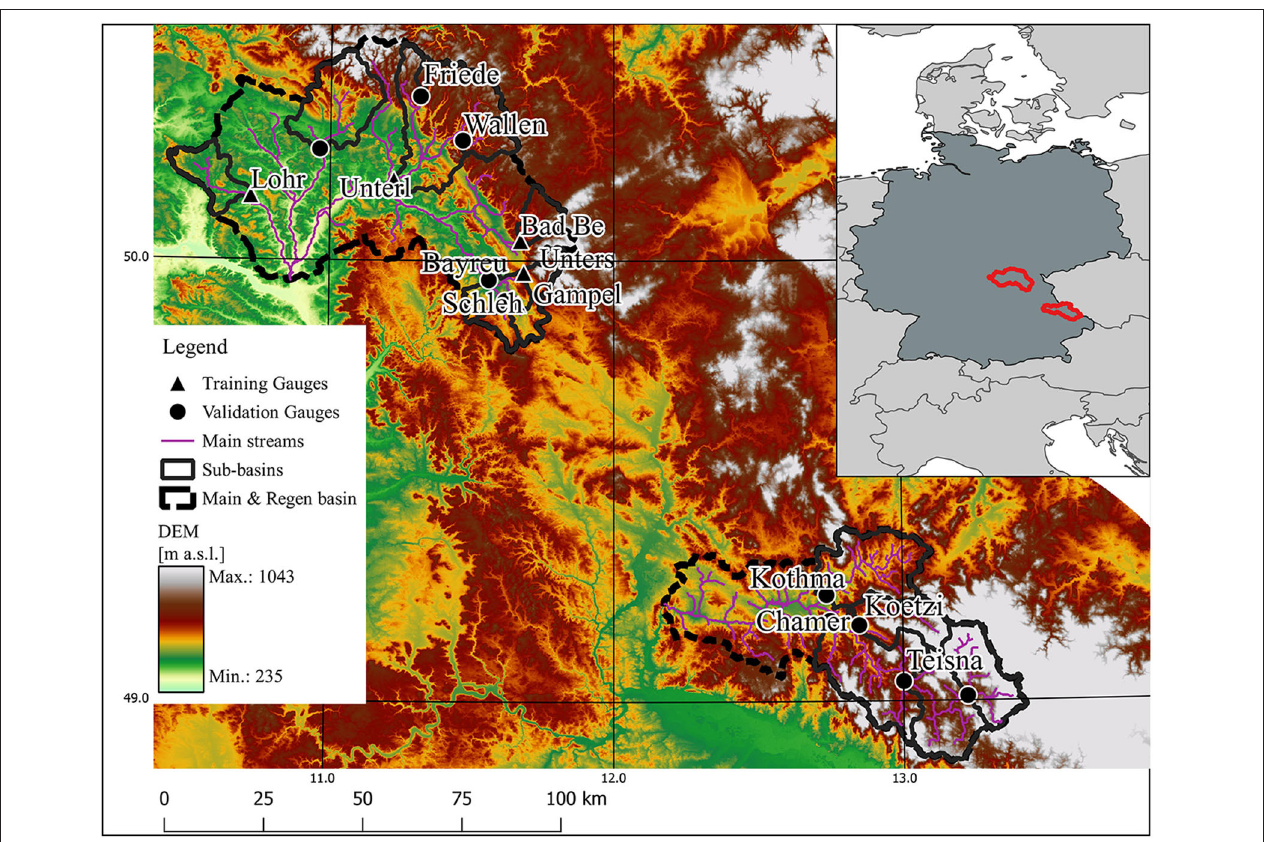
FIGURE 2 | Case study basins of the Upper Main (upper left) and Regen (lower right) in south-east Germany. Five gauges (triangle) have been used for local application and as training data for (trans-) regional application (circle).